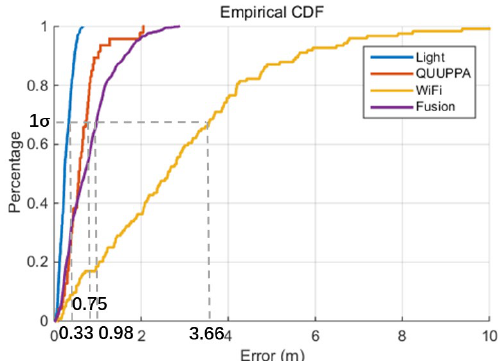
Figure 5. Positioning cumulative error percentages of the four different solutions.